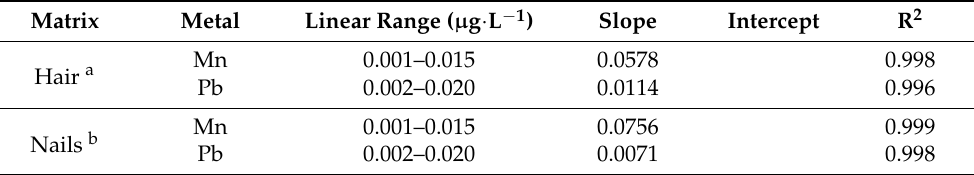
Table 4. Linearity